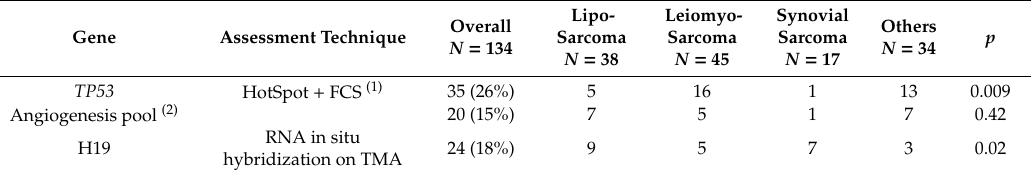
Table 2. Frequency of mutation or positivity for H19, TP53 , and angiogenesis